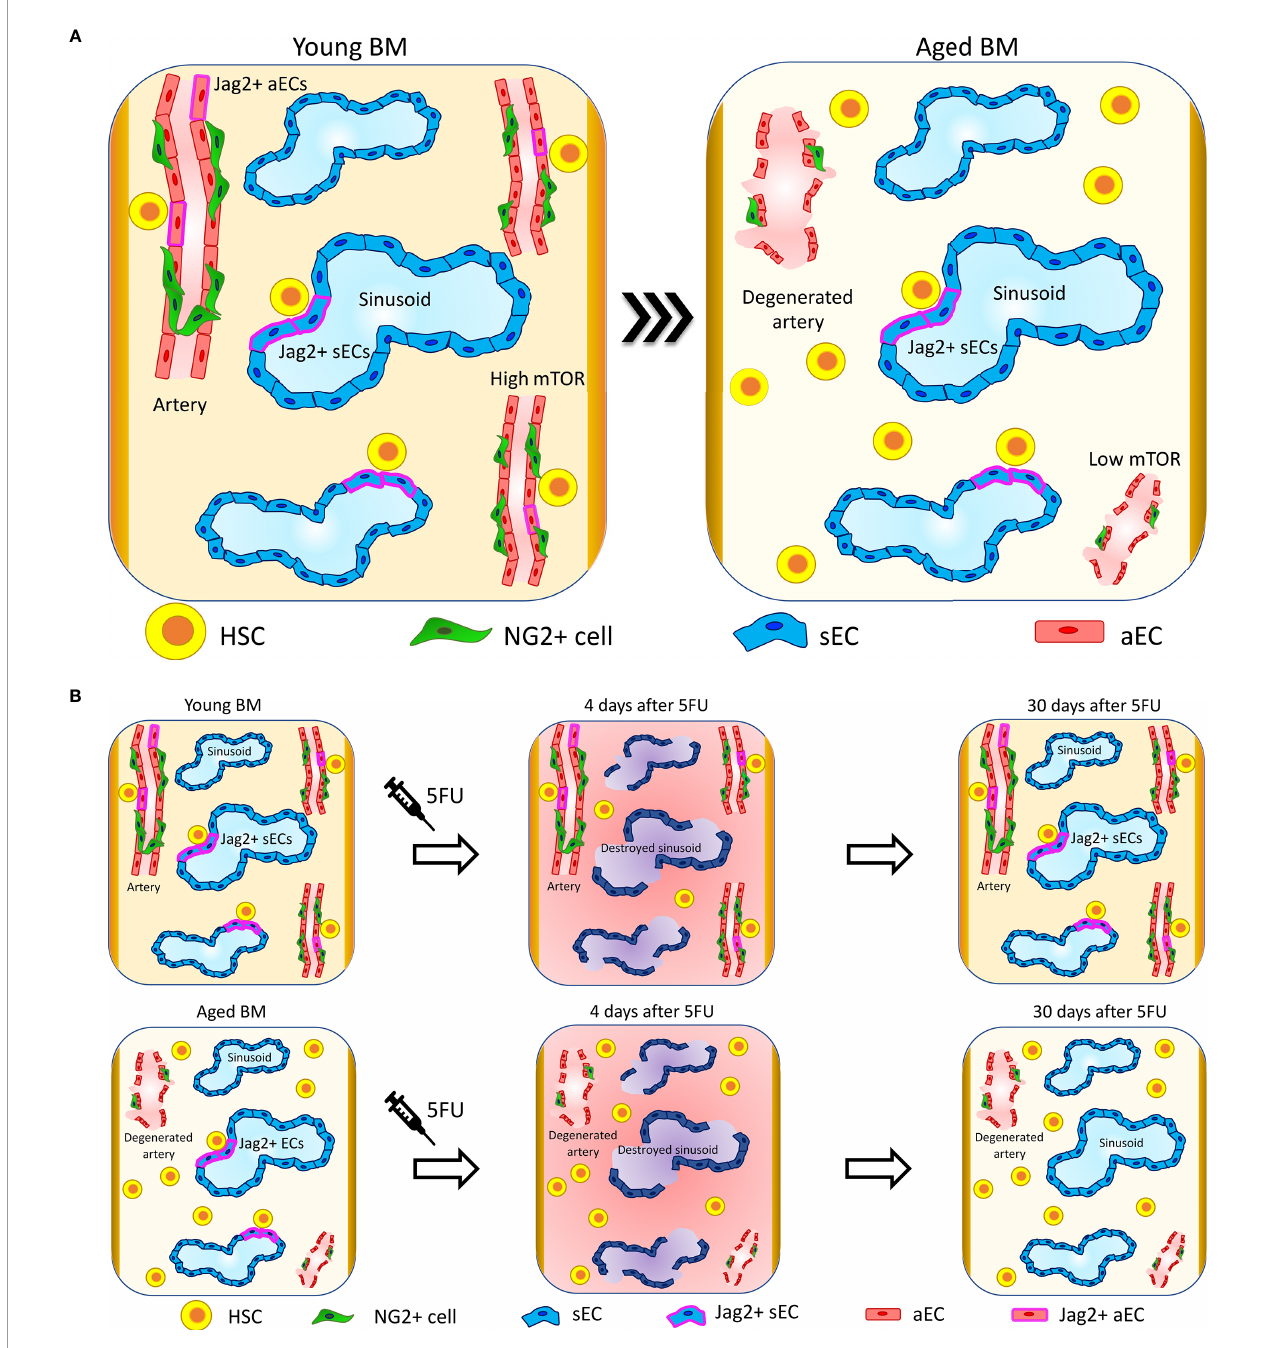
FIGURE 1 | Vascular niche upon aging. (A) Upon aging, arteries and arterioles degenerate, changing their orientation and reducing their length (41, 75). Interestingly, speci fi c HSC-supporting signalings are lost at the arteries. In particular, Jag2 expression is lost at arterial ECs (aECs) (40) and mTOR is downregulated (77). The sinusoidal niche preserves its structure and functionality, and sinusoidal ECs (sECs) maintain the signaling involved in the support of HSC functions. In line with these changes, HSC localization in proximity to arteries and arterioles is reduced and HSCs migrate far away. Conversely, HSCs retain their localization in proximity to sinusoids (40). (B) Four days after 5FU treatment, sinusoids are destroyed and there is a global increase in in fl ammation in both young and aged mice. Thirty days after 5FU administration, young mice recover sinusoidal vascular integrity and Jag2 expression while aged mice show only a partial restoration of sinusoidal vascular integrity and almost no recovery of Jag2. These correlate with aged HSCs localizing signi fi cantly further from sinusoids compared to control not 5FU-treated and presenting with increased clustering